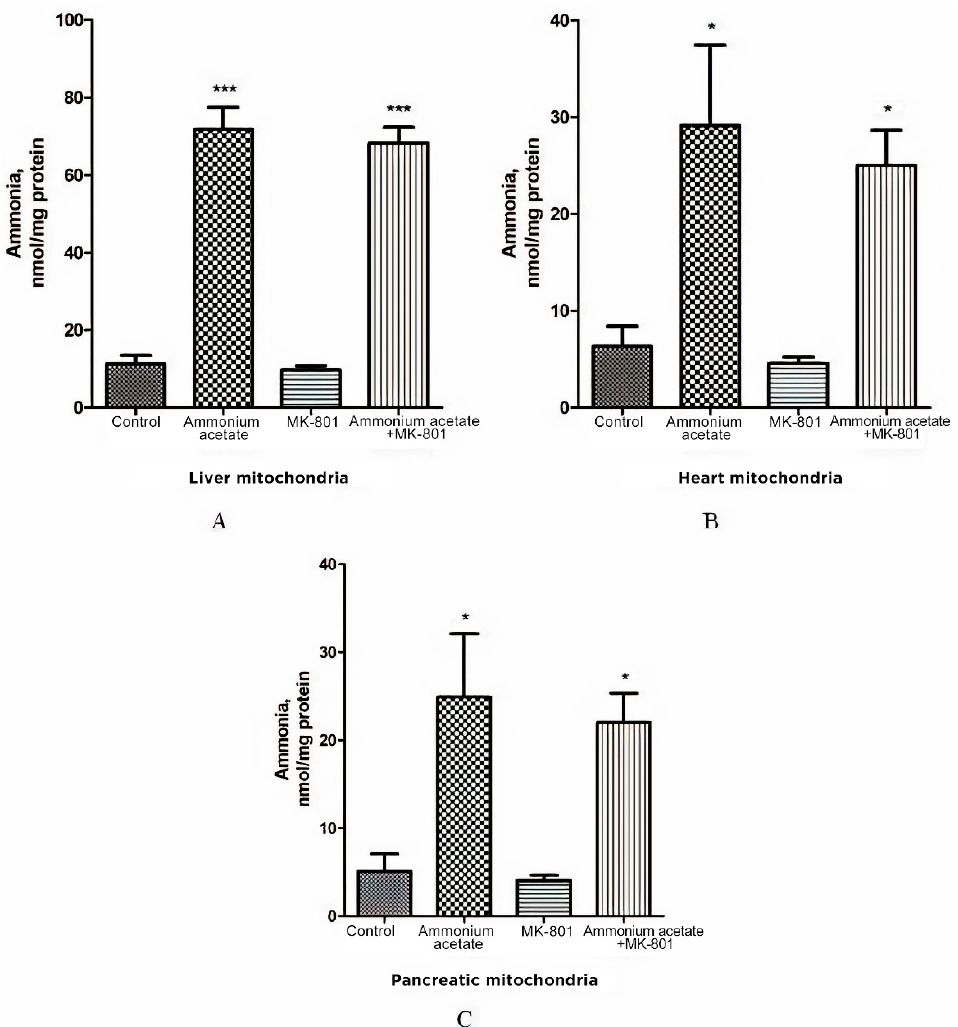
Figure 2. Effect of injection of ammonium acetate and/or MK-801 on ammonia concentration in mitochondria isolated from rat liver ( A ), heart ( B ), and pancreas ( C ). Immediately after decapitation, the tissues were removed, and mitochondria were isolated and assayed for ammonia levels, as indicated in Materials and Methods. Other experimental conditions were the same as in Figure 1 legend. The results are presented as mean ± SEM. Values significantly different from the control group are designated with one (*) and three (***) asterisks: * p < 0.05, *** p < 0.001 (Student’s t -test).